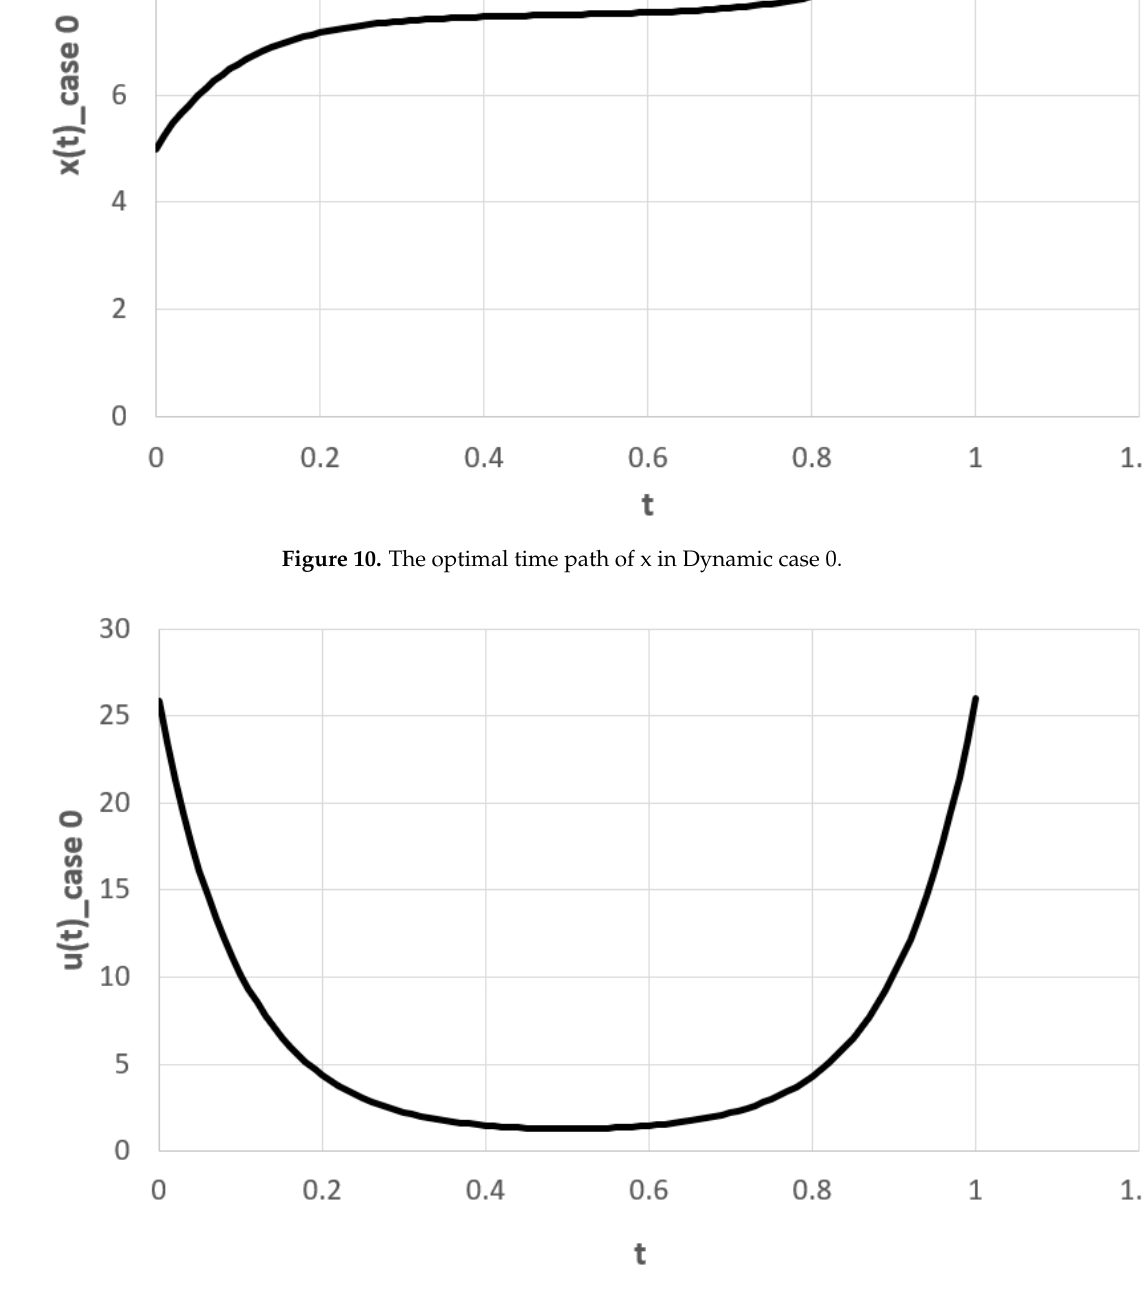
Figure 11. The optimal time path of u in Dynamic case 0.